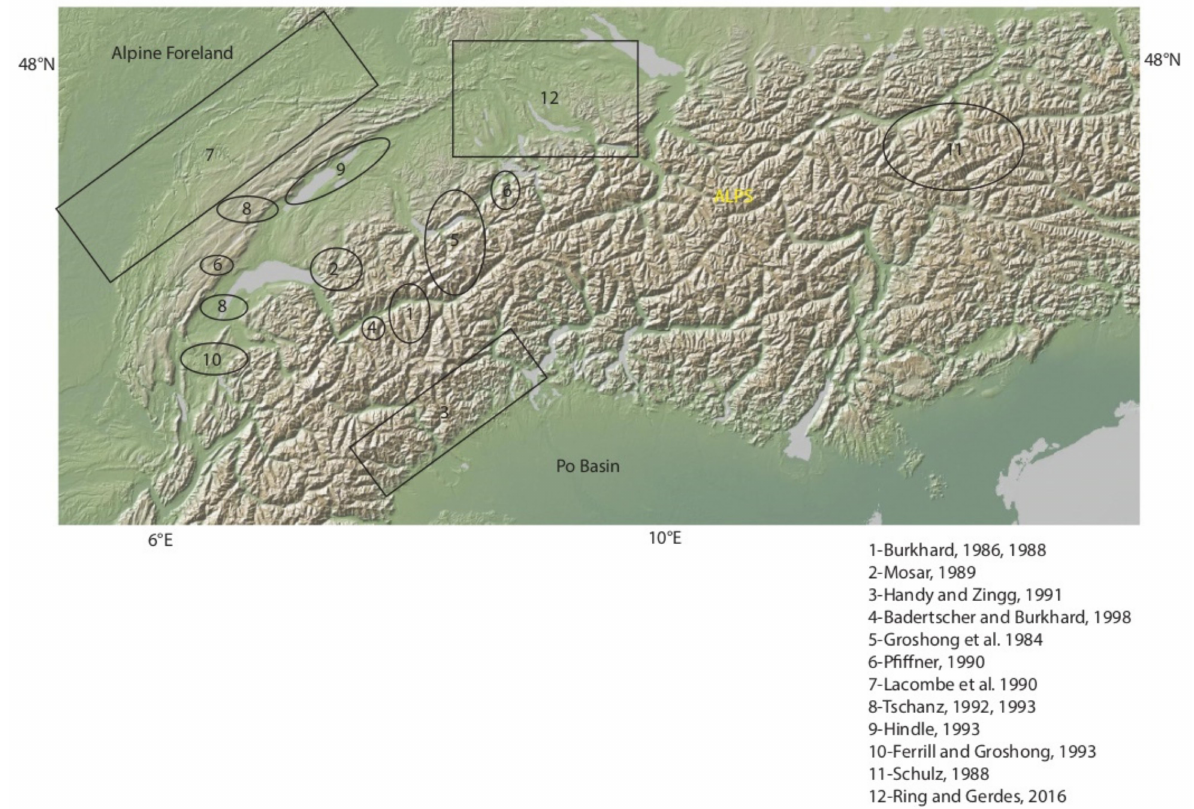
Figure A1. DEM of Alpine strain study